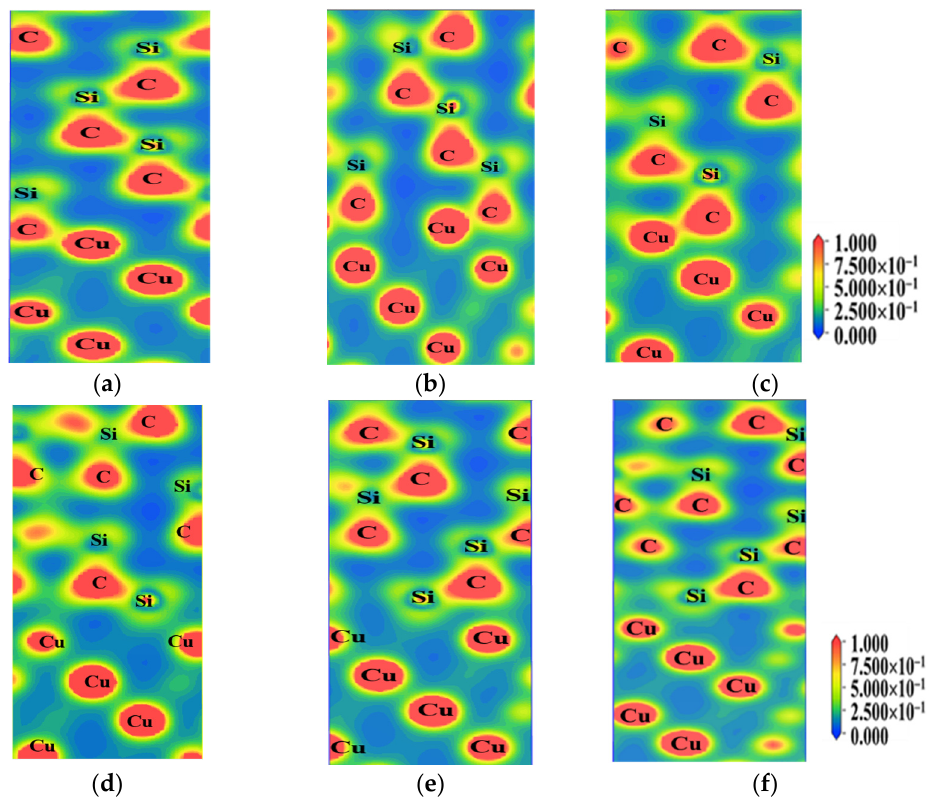
Figure 5. Charge density distribution of the interfacial atoms of all “(a)” types of 6H-SiC(0001)/Cu(111) interfacial models along (211) interface (eV/Å 3 ). ( a ) CT-HCP(a); ( b ) CT-MT(a); ( c ) CT-OT(a); ( d ) ST-HCP(a); ( e ) ST-MT(a); ( f ) ST-OT(a).